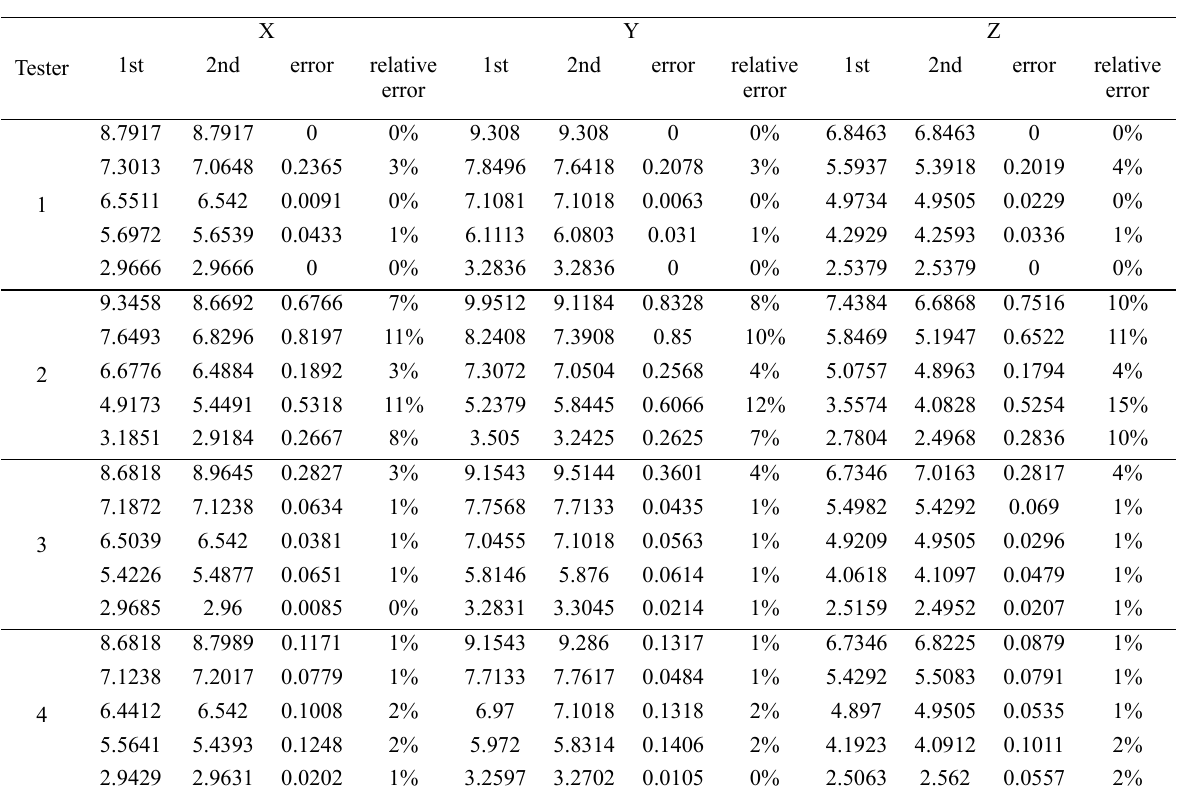
Table 2. Sample points placing error analysis of the west side pattern in Liujia